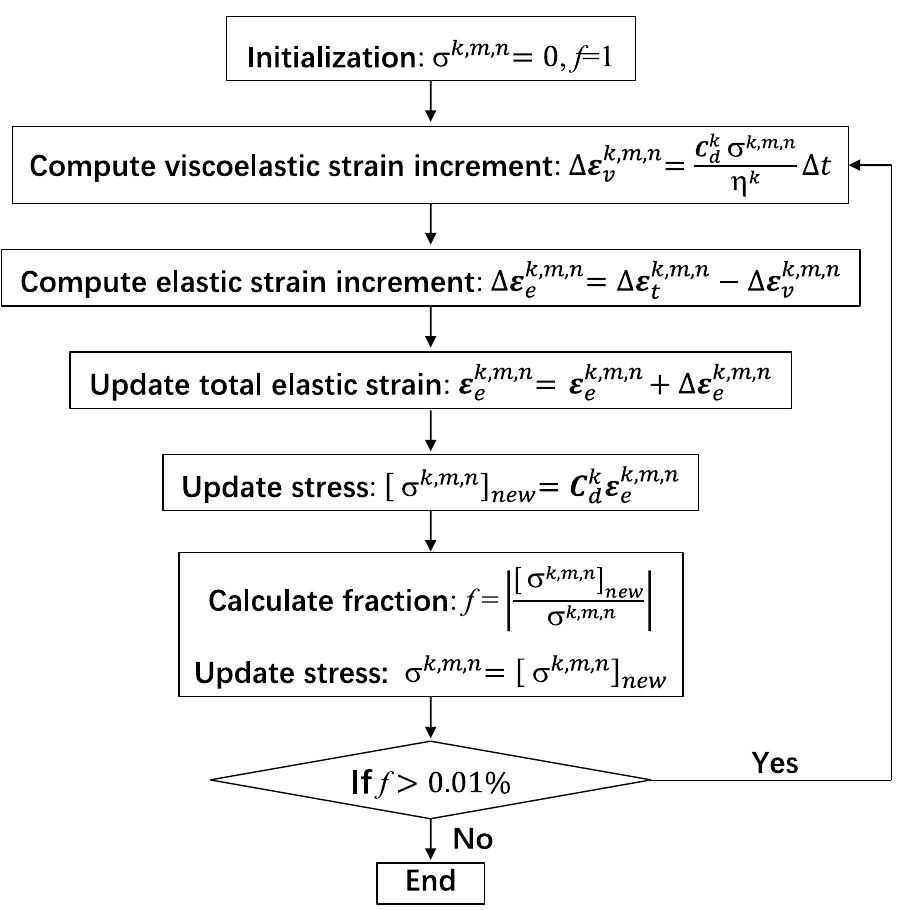
Figure 8. Flowchart for updating stress at the integration point.